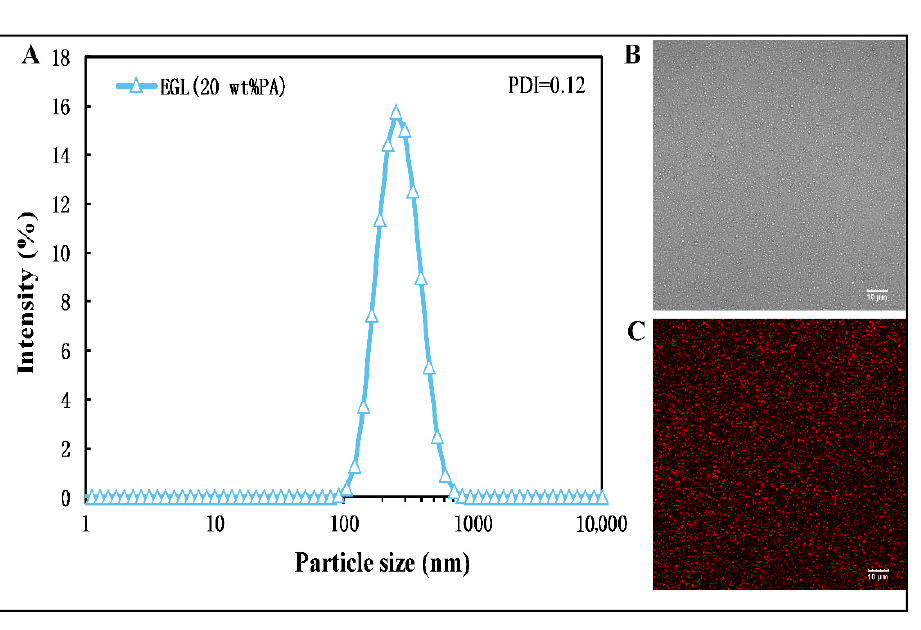
Figure 1. Particle size distribution ( A ) and microstructure ( B , C ) of limonin-loaded eugenol nanoemulsion. The mean particle size was 245.7 nm. Scale bar, 10 μ m.